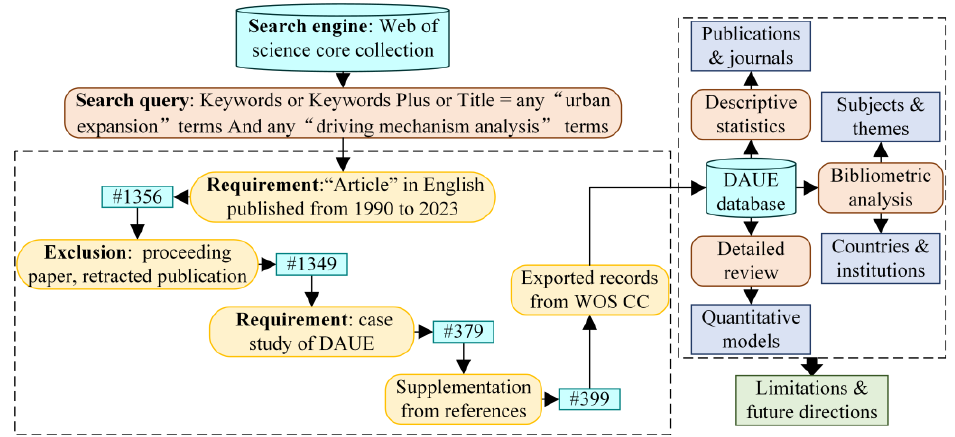
Figure A1. Flowchart of data collection and systematic review.